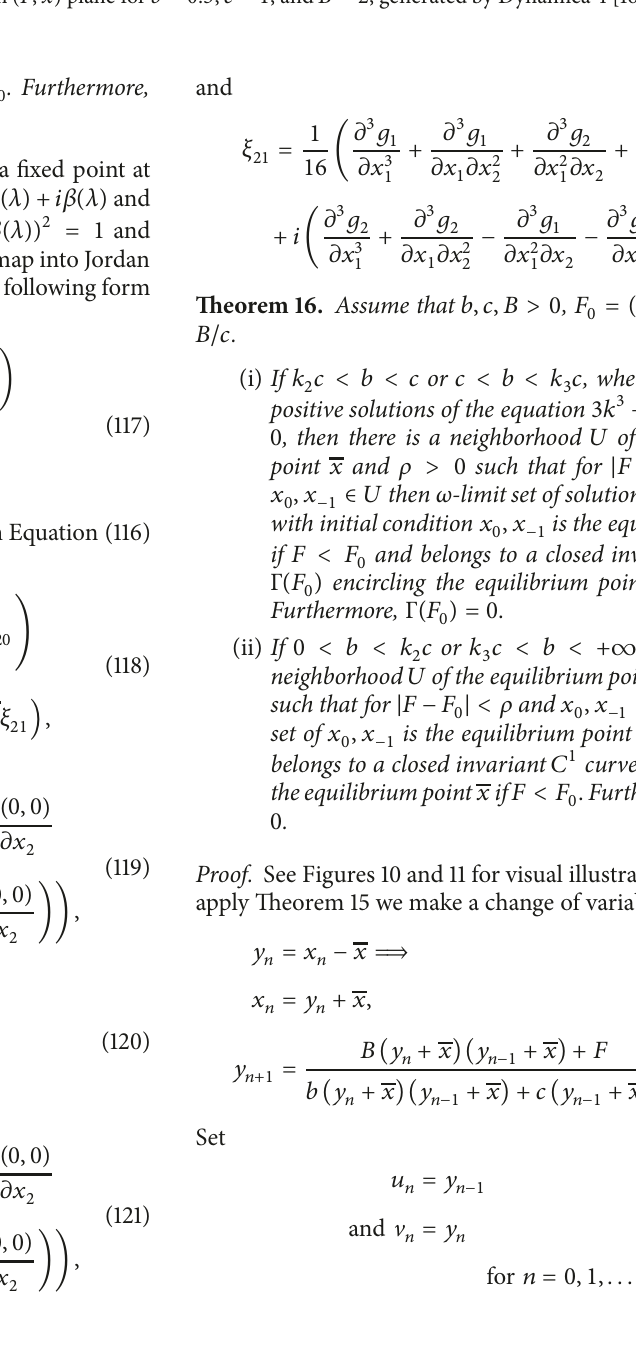
Figure 10: Bifurcation diagrams in (𝐹,𝑥) plane for 𝑏 = 0.5 , 𝑐 = 1 , and 𝐵 = 2 , generated by Dynamica 4 [16].